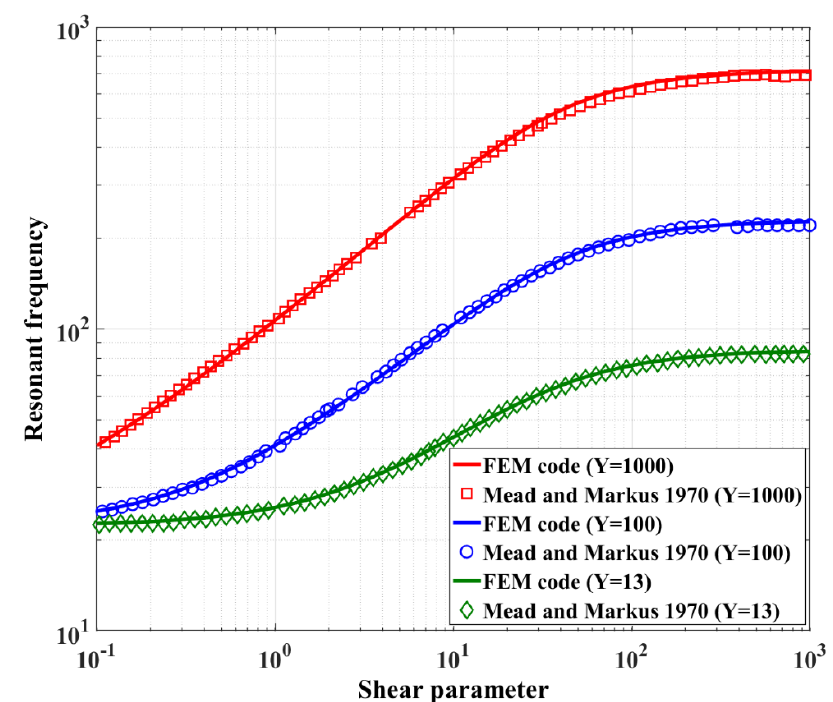
Figure 8. Comparison of the results of the developed finite element (FE) model with analytical results of Mead and Markus 1970 [22].